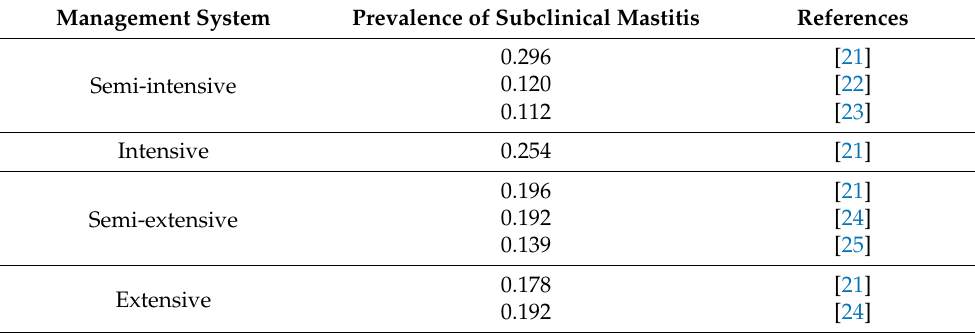
Table 1. Prevalence of subclinical ovine mastitis in different management